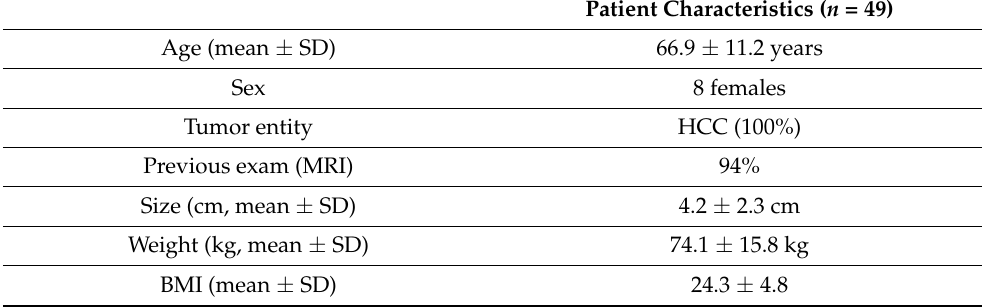
Table 1. Patient characteristics.